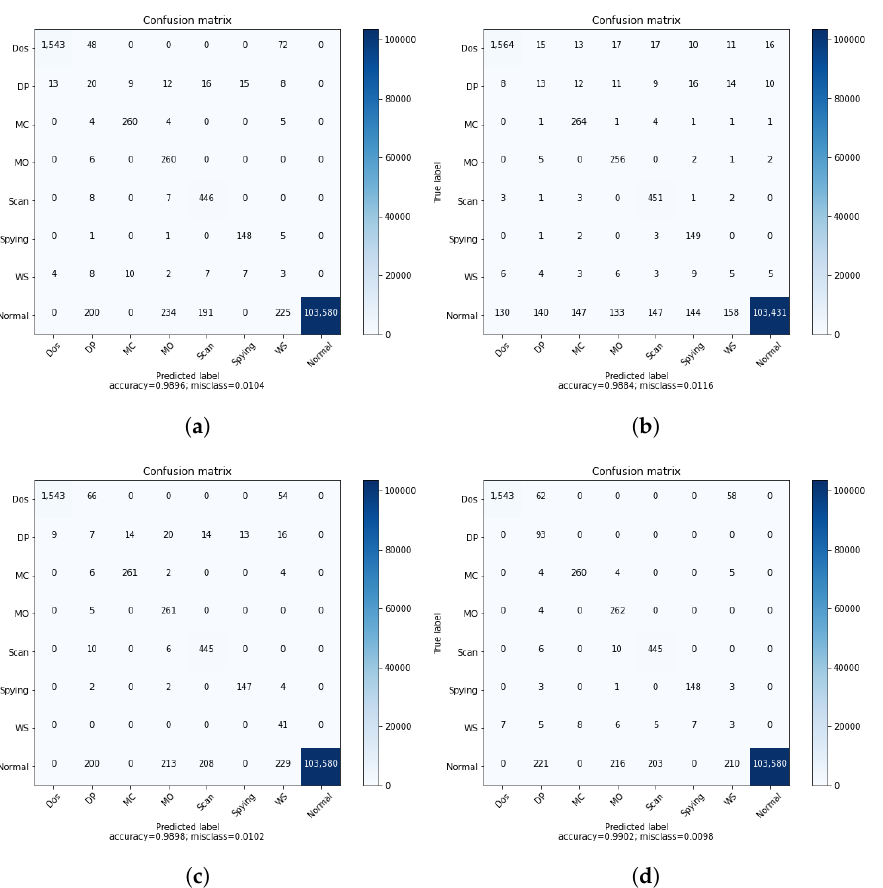
Figure 5. Confusion matrices of multi-class classification. ( a ) Normal DRL. ( b ) DRL with GAN 1 . ( c ) DRL with GAN 2 . ( d ) DRL with GAN 3